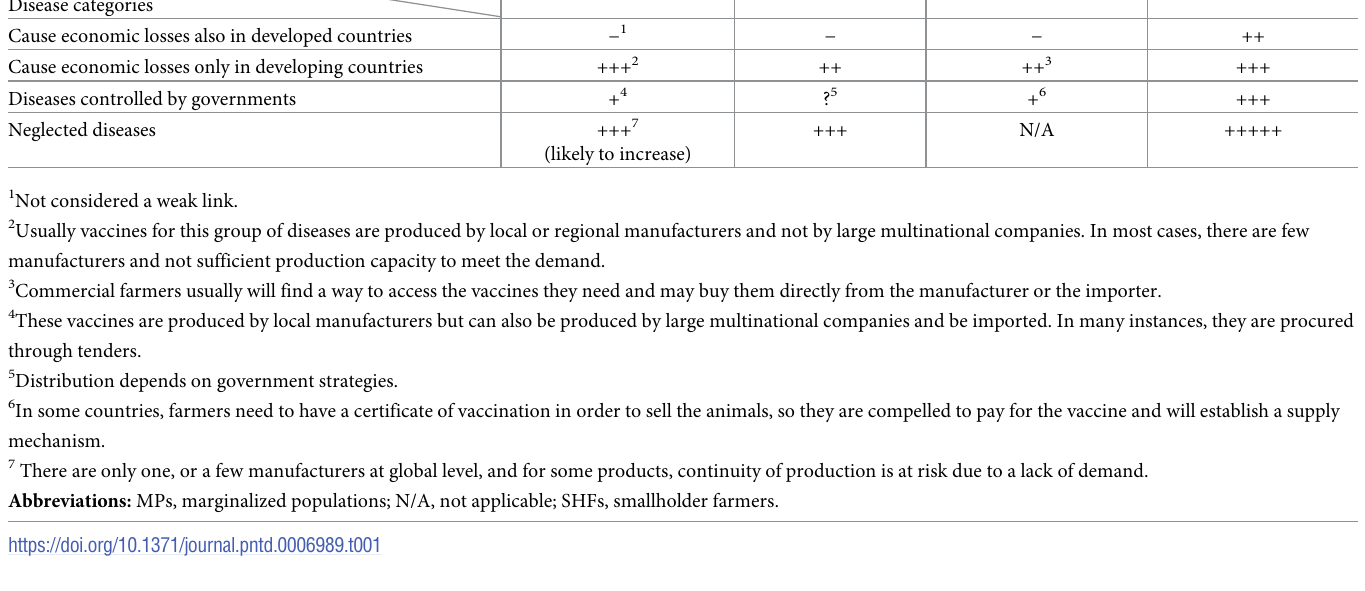
Table 1. Weak links in the supply chain of existing animal vaccines according to the different disease categories. Increased level of weakness is represented by a larger number of +. Vaccine supply